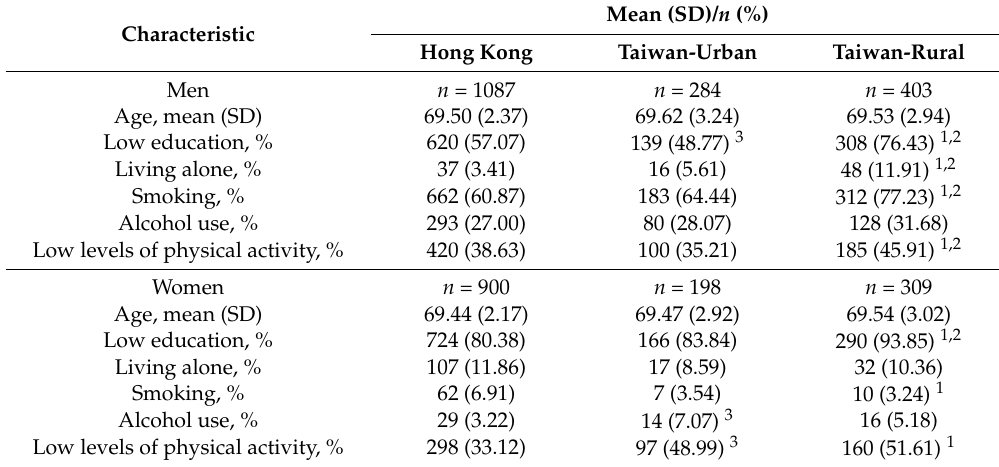
Table A2. Population characteristics between Hong Kong, Taiwan-urban and Taiwan-rural: age 65–74.